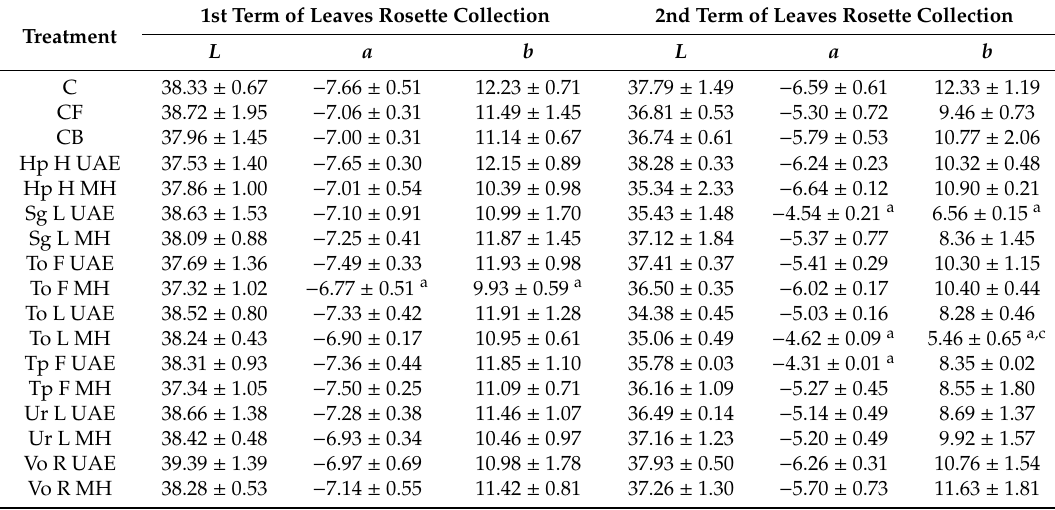
Table 2. E ff ect of the foliar application of botanical extracts on the L , a , b values of celeriac leaves (N = 10, mean ±